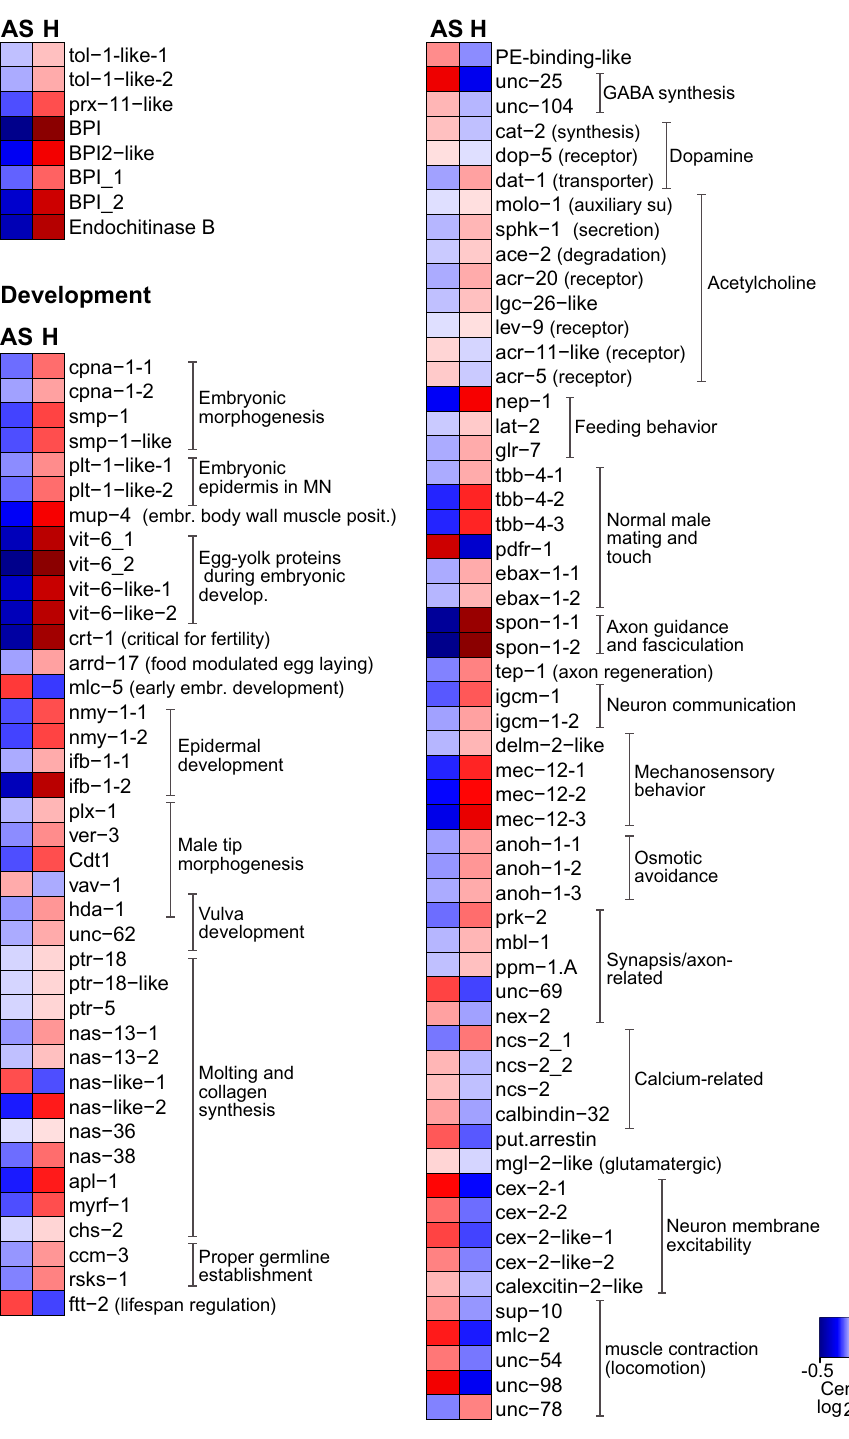
Figure 5. Genes involved in immune response, development and nervous system were predominantly expressed in hypoxic (H) worms. Heatmap displaying genes upregulated in H relative to AS worms, upon 24 h-long incubations under one of the two conditions (1.5-fold change, FDR ≤ 0.05). Expression levels are displayed as mean-centered log 2 TPM value (transcripts per kilobase million). Genes are ordered by function in their respective metabolic pathways. For each process, the minority of genes that were upregulated in AS worms is shown in Data S1. Red denotes upregulation and blue downregulation. MN, mechanosensory neurons; Embr. body wall muscle posit.: Embryonic body wall muscle positioning; Put.;